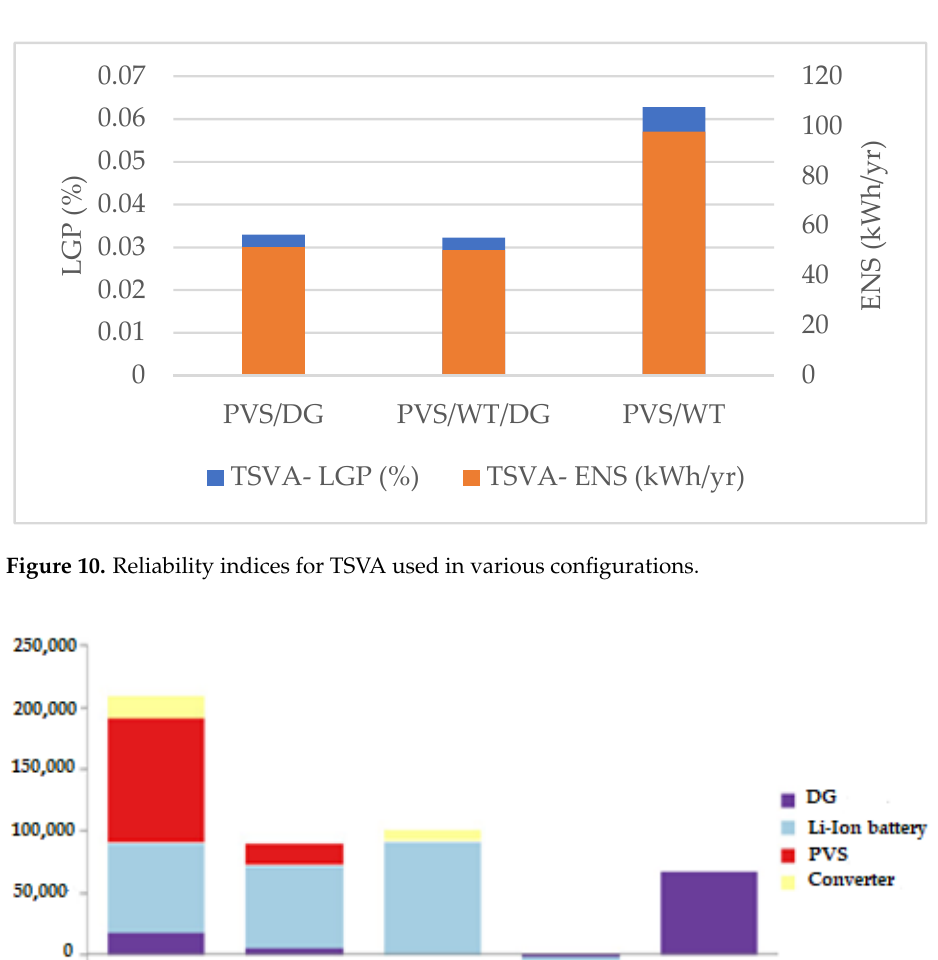
20 of 34 Figure 9. Comparison of TSVA in various hybrid configurations. 4.4. Reliability Assessment for Solar DG Source Configuration with TSVA In Figure 10, the reliability indices for tracking system on a vertical axis (TSVA) are used in various configurations. The optimization results show that the expected energy not served (ENS) for PVS/DG, PVS/WT/DG and PVS/WT are 51.5 kWh/yr, 50.3 kWh/yr